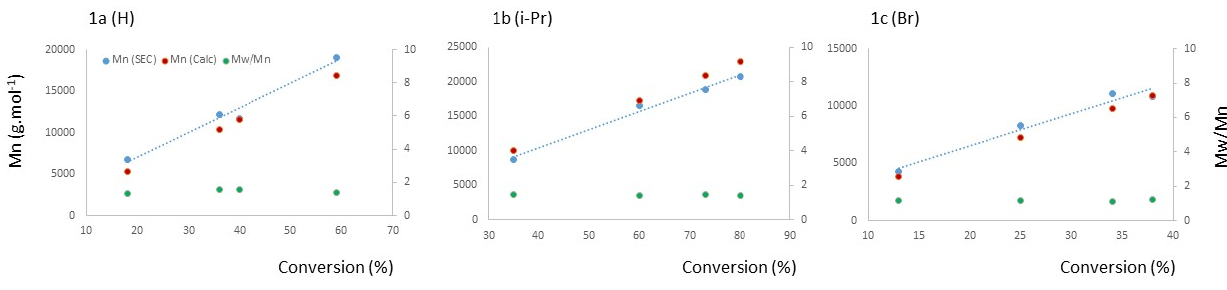
Figure 5. Number-average molar mass ( M n ) and dispersity ( M w / M n = Đ vs. conversion for samples 1a (H), 1b ( i -Pr) and 1c (Br). Dotted blue ( M n obtained by SEC), dotted red ( M n calculated), dotted green ( M w / M n obtained by